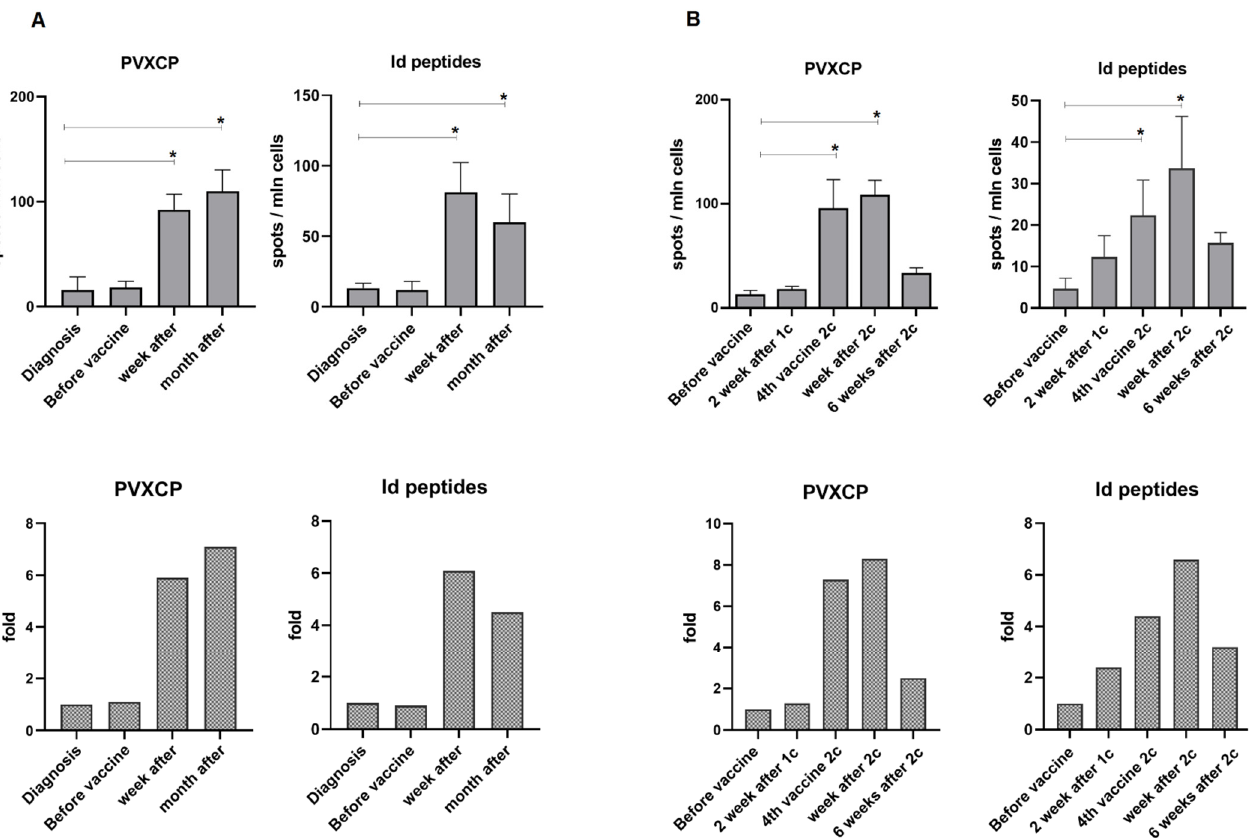
Figure 3. ELISpot test for patients 12Os ( A ) and 7T ( B ). The T-cell response is presented as the number of spots per million cells at each point (mean and SD), and the mean fold increase in response relative to the primary point. There are no data for the fourth vaccine of the patient 12Os. 1c—first vaccine course, 2c—second vaccine course (indicated only for patients who had two courses of vaccination). A significant difference ( p < 0.05) in the number of spots between time points is indicated by the asterisk (Student’s t -test).